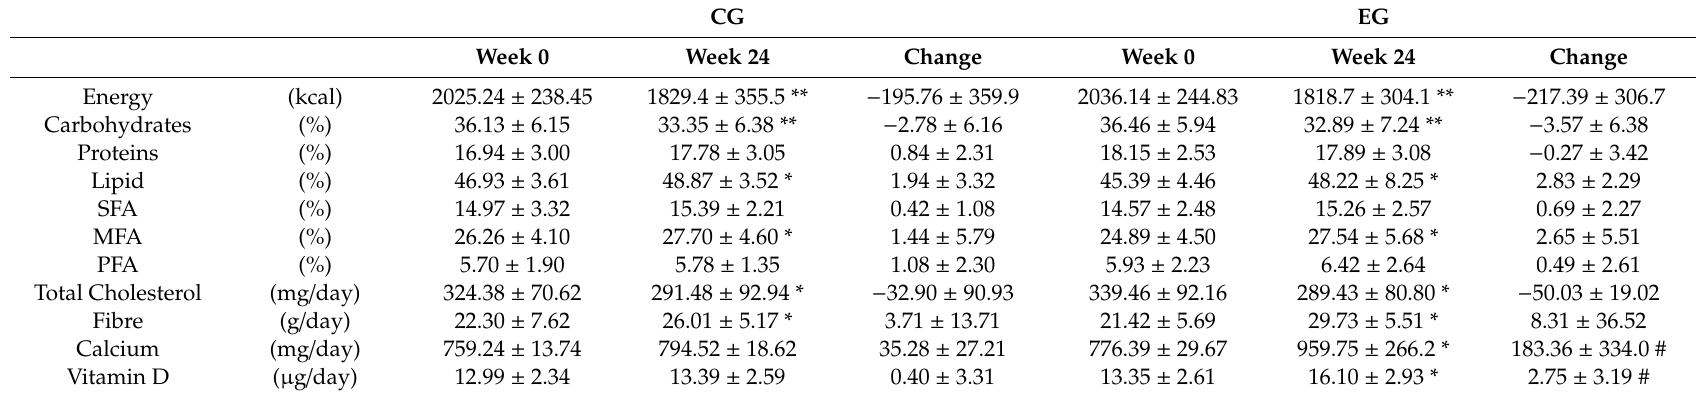
Table 3. Dietetic intake of the study participants before and after the